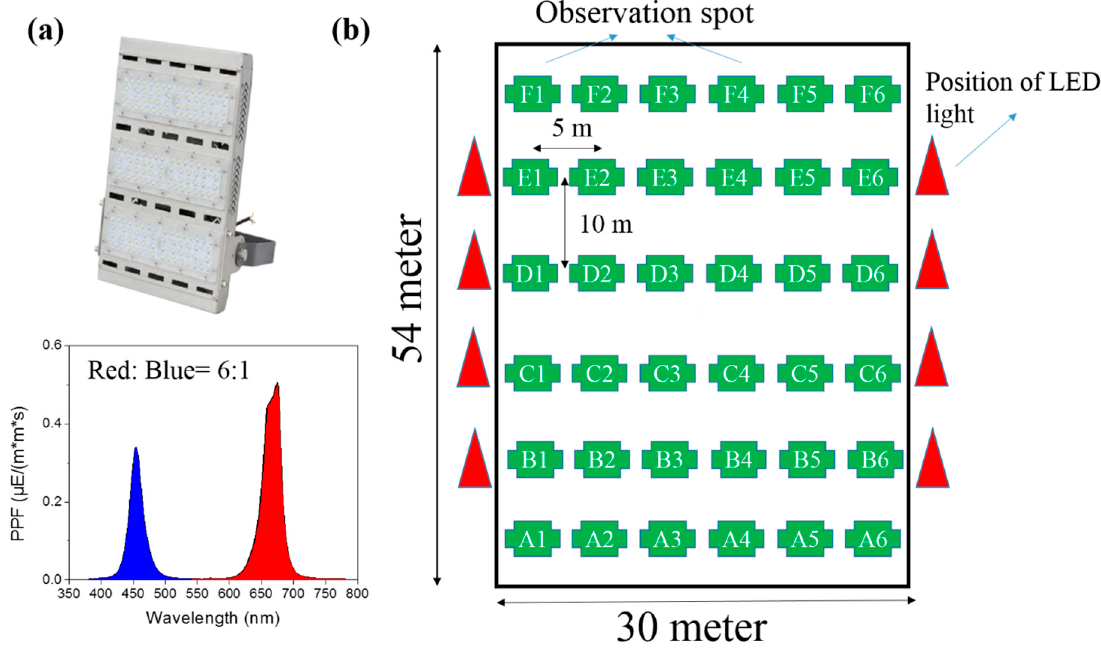
Figure 2. ( a ) LED lamp module and blue ( λ peak = 460 nm) and red ( λ peak = 670 nm) LED light spectrum. ( b ) Schematic of the area and observation section of the water bamboo field.